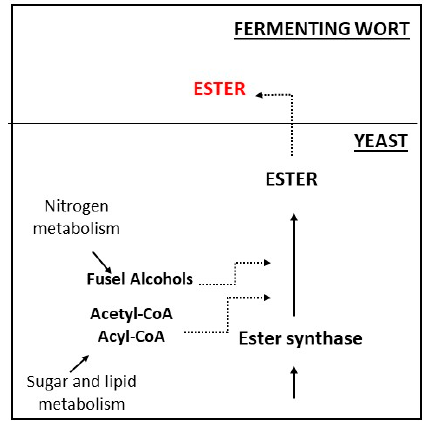
Figure 1. Ester synthesis pathway: During yeast metabolism, fermentable sugars and lipids are converted into acetyl-CoA and nitrogen metabolism induces the formation of fusel alcohols. These compounds are further used to produce ester molecules by the catalytic activity of the enzyme ester synthase. The picture was adapted from Verstrepen et al. (b) [39].